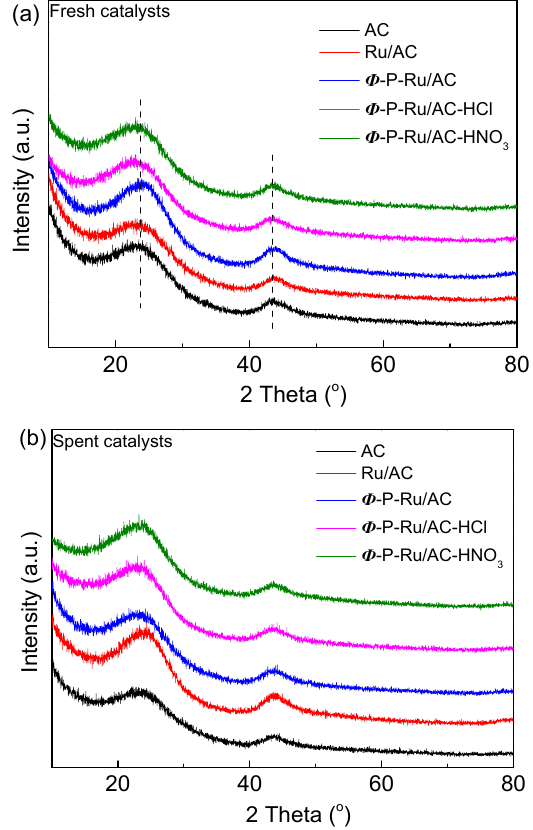
Figure 4. XRD patterns of the fresh ( a ) and spent ( b ) Ru-based catalysts.